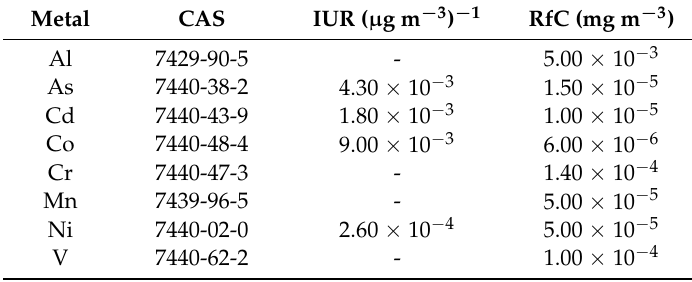
Table 3. Inhalation Unit Risk (IUR) and Reference Concentration (RfC) data from USEPA